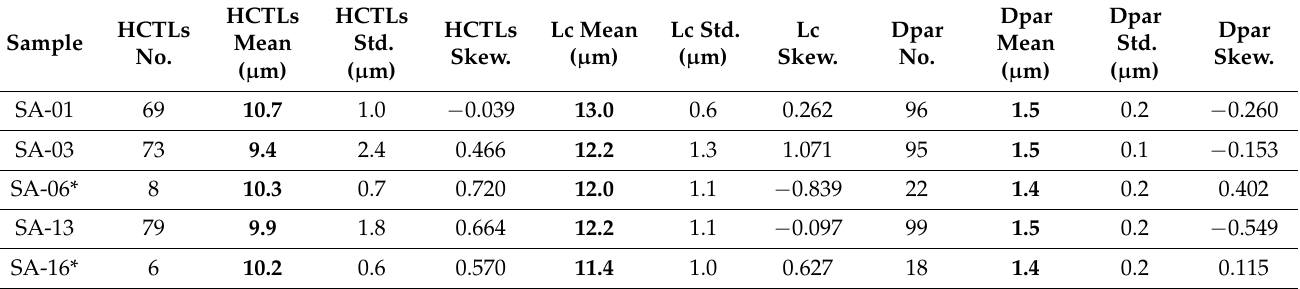
Table 3. Detailed length and Dpar data of the apatite horizontal confined